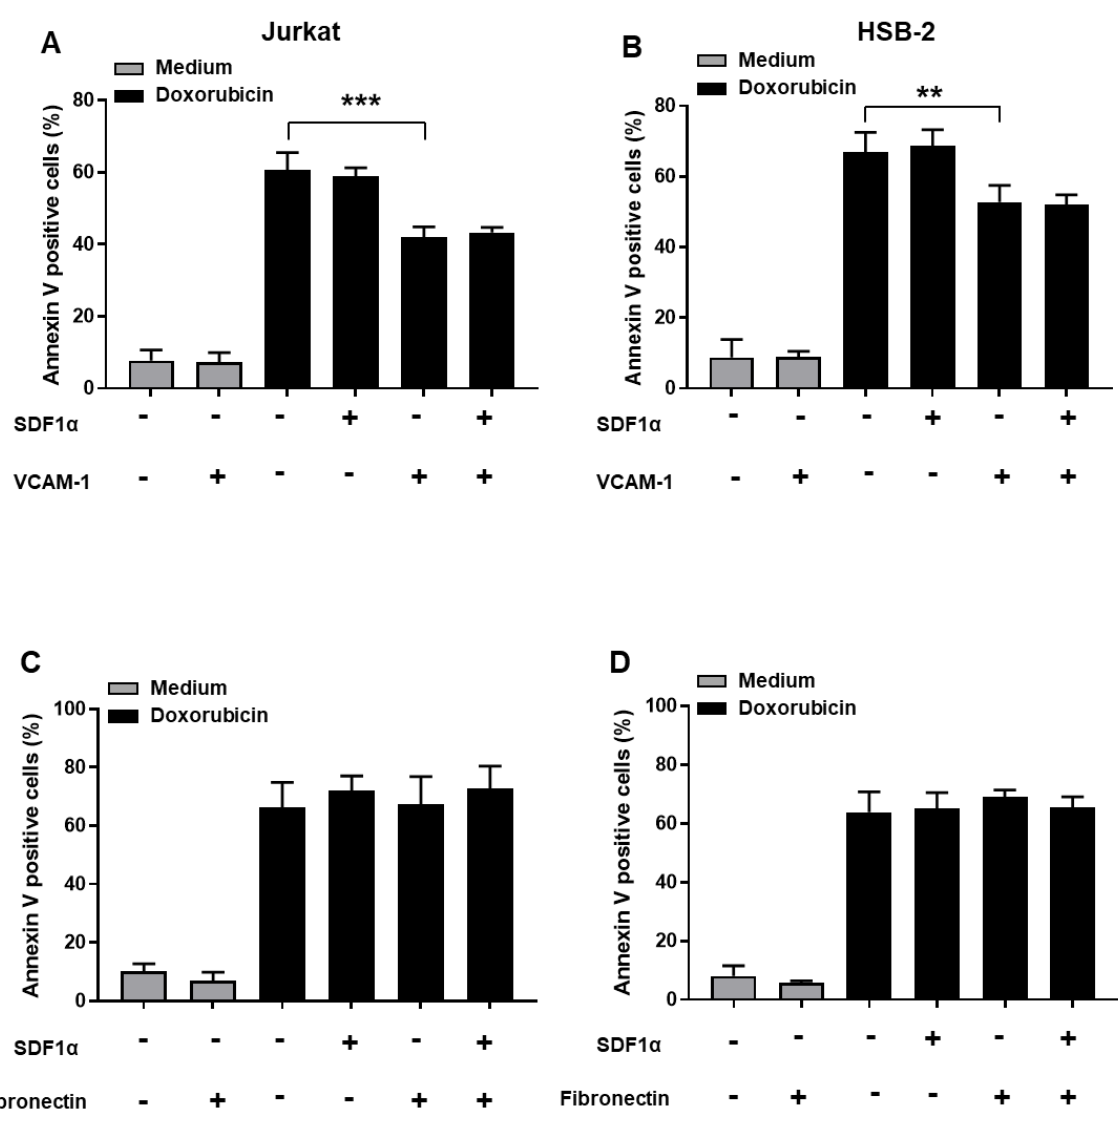
Figure 3. VCAM-1 but not fibronectin induces resistance of human T-ALL cell lines to doxorubicin. Jurkat ( A , C ) and HSB-2 cells ( B , D ) were pre-activated or not with SDF1 α for 1 h and then seeded on VCAM-1, fibronectin or BSA for 4 h. The non-adherent cells were removed by washing three times with the RPMI medium and adherent cells were treated for 48 h with 50 ng/mL and 10 ng/mL of doxorubicin for Jurkat and HSB-2 cells respectively. Apoptosis was determined by annexin V staining and FACS analysis. Results represent mean values ± S.D. of three independent experiments. ** p < 0.01 and *** p < 0 .001 determined by the Student’s t -test.